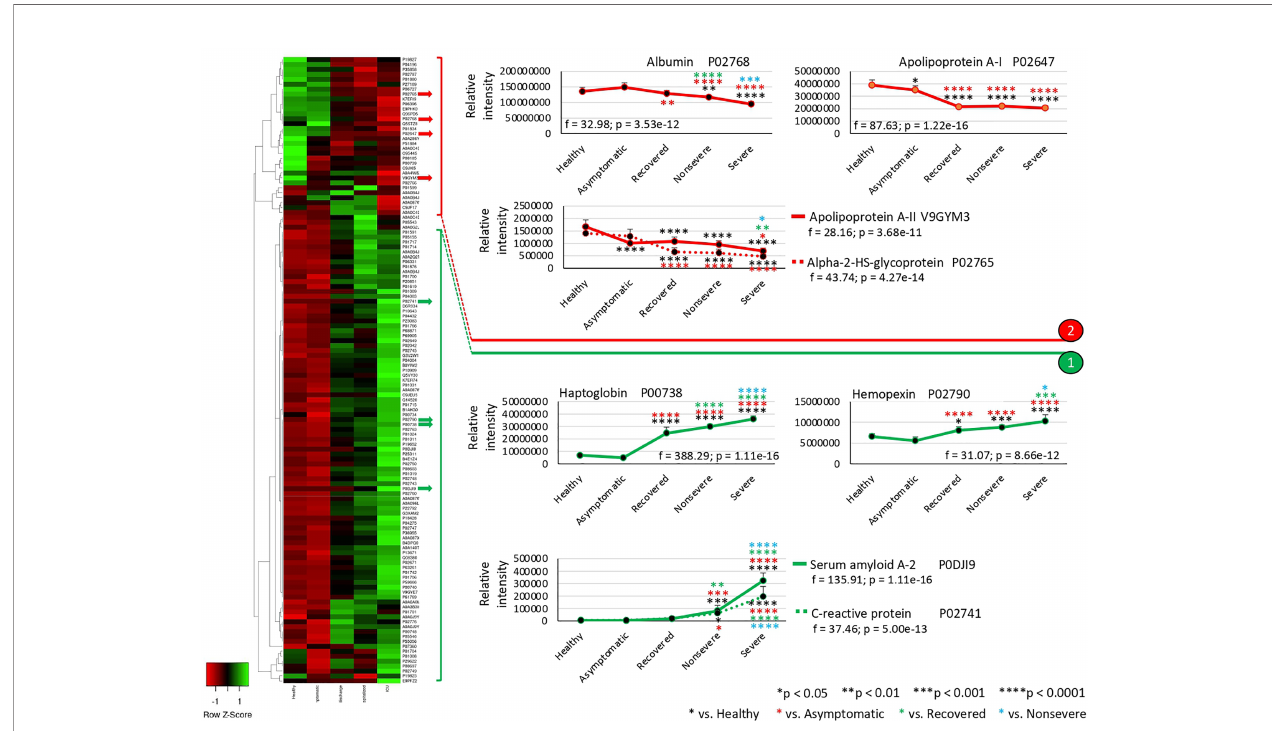
FIGURE 4 | Multiple differential representation of proteins in sera from COVID-19 cases. Heatmap of proteins signi fi cantly dysregulated ( Z -scored original value) in multiple COVID-19 cohorts ( p < 0.05; unpaired two-sided Welch ’ s t -test). Clusters of proteins differentially represented in response to COVID-19 (cluster 1, overrepresented; cluster 2, underrepresented) are shown. Protein levels of four selected proteins with signi fi cant differences on each cluster were compared between groups by one-way ANOVA test followed by post-hoc Bonferroni and Holm multiple comparisons ( f -values and p -values are shown) and unpaired two-sided Welch ’ s t -test (* p < 0.05, ** p < 0.01, (*** p < 0.001, **** p <